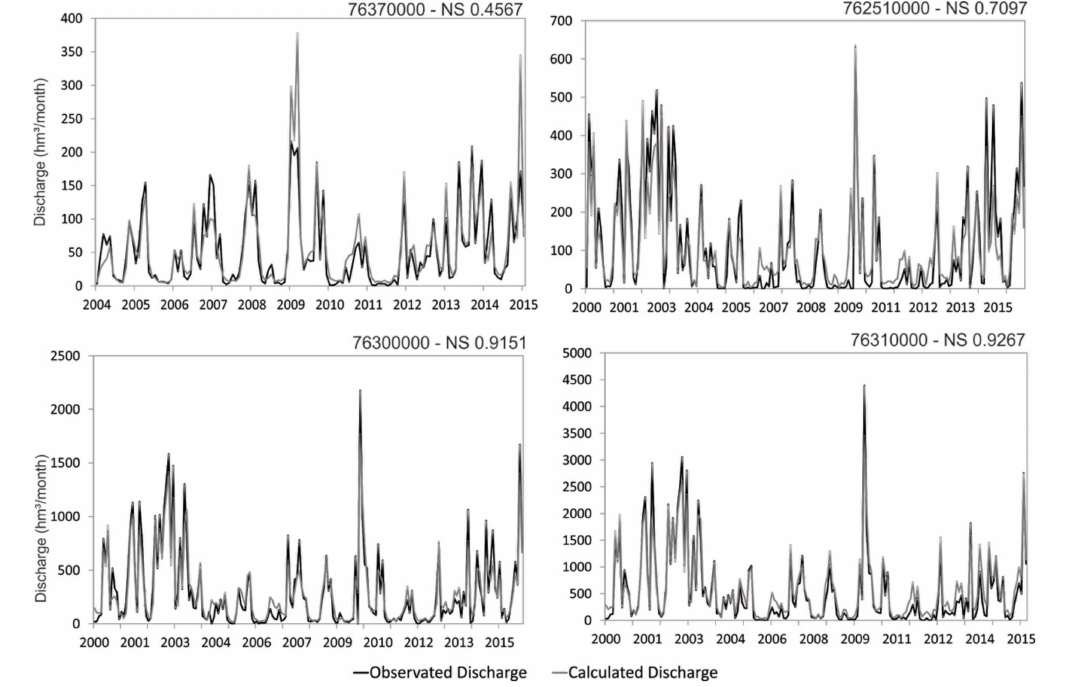
Figure 3. Discharge calibration with the MGB-IPH model for the gauging